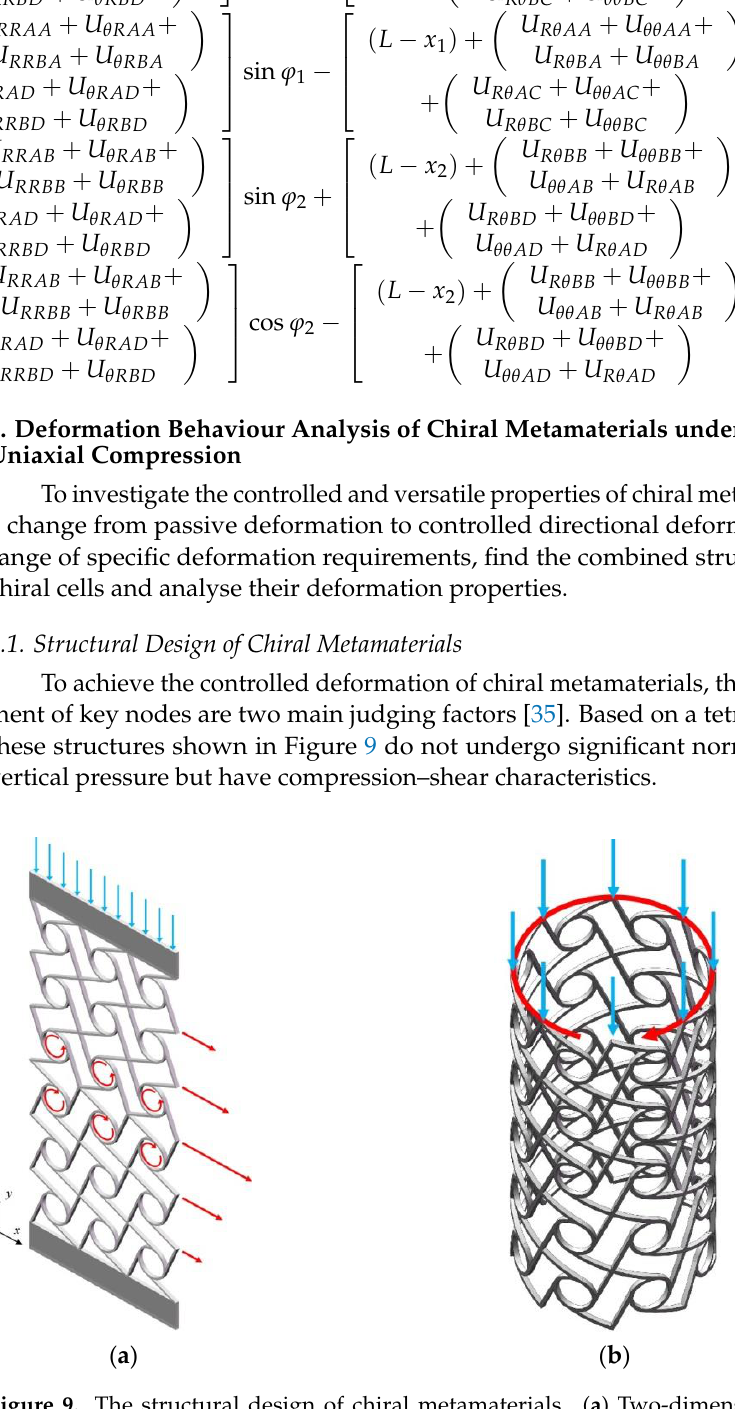
Figure 9. The structural design of chiral metamaterials. ( a ) Two-dimensional planar structure; ( b ) Three-dimensional cylindrical shell structure.